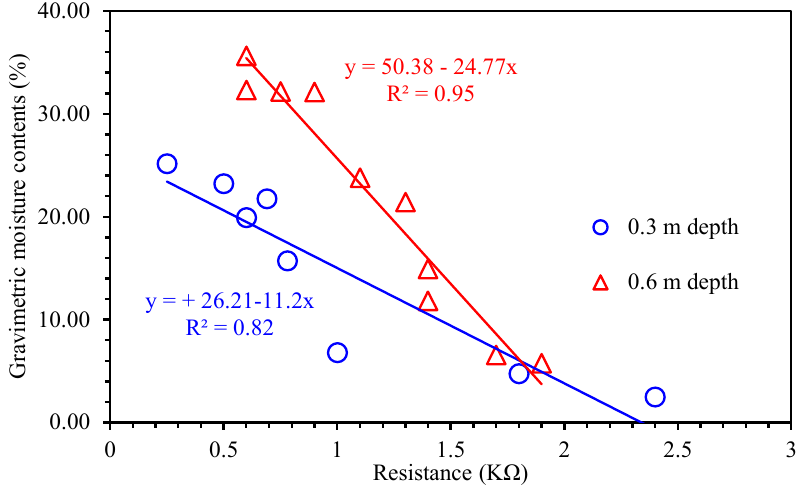
Figure 7. Calibration curves of gypsum blocks with gravimetric moisture contents at 0.3 and 0.6 m depths.